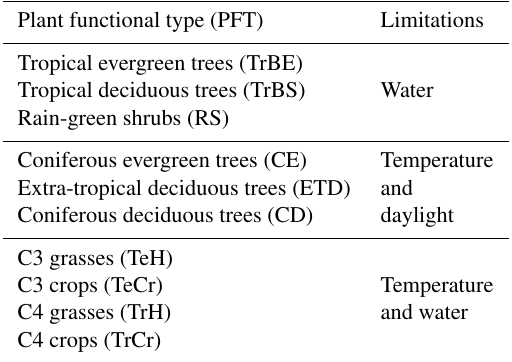
Table 1. Plant functional types (PFTs) in the JSBACH model and the limitations that control the phenological behaviour of the re- spective